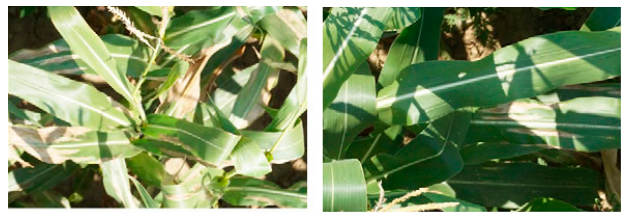
Figure 7. Image samples for lesion spot detection; maize leaves with different natural lighting angles and complex surroundings [122].